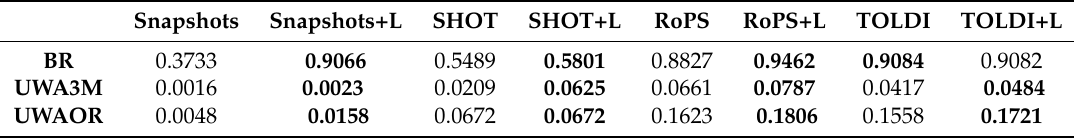
Table 3. Overall accuracy of eight LRF-based descriptors with LRF-Net (denoted by L) and their original LRFs on the BR, UWA3M, and UWAOR